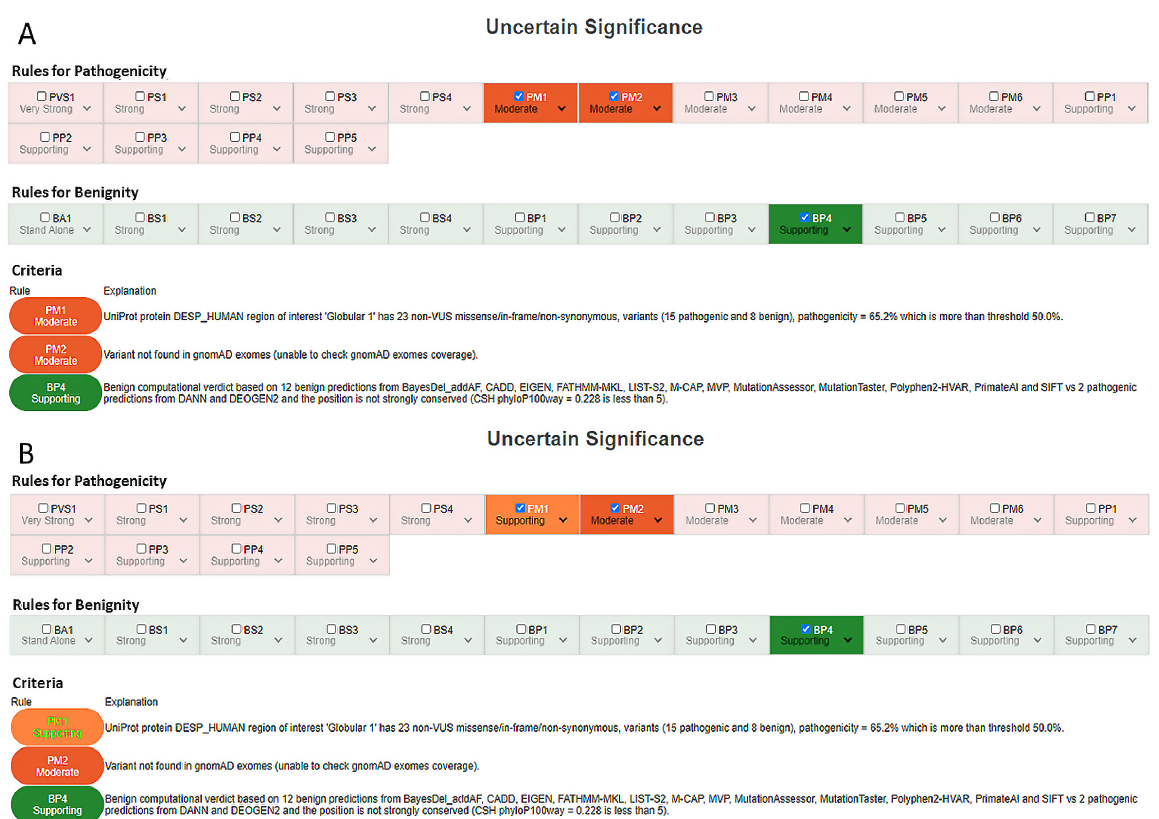
Figure 3. ( A ) Automatic classification for c.2582C>T p.(Thr861Ile) in the DSP gene and ( B ) downgrading of PM1 to Supporting due to the length of the “Globular 1“ region of interest (1–1056